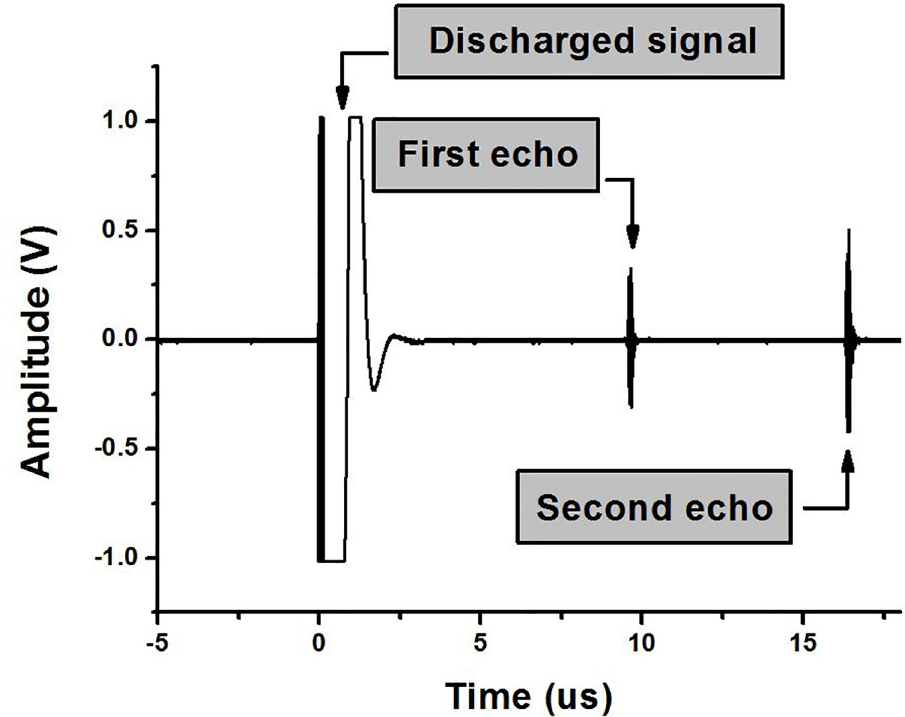
Fig 13. Discharged signal and ultrasonic echo signal transmitted and received by a high-efficiency and high- voltage class F amplifier and 25 MHz transducers.